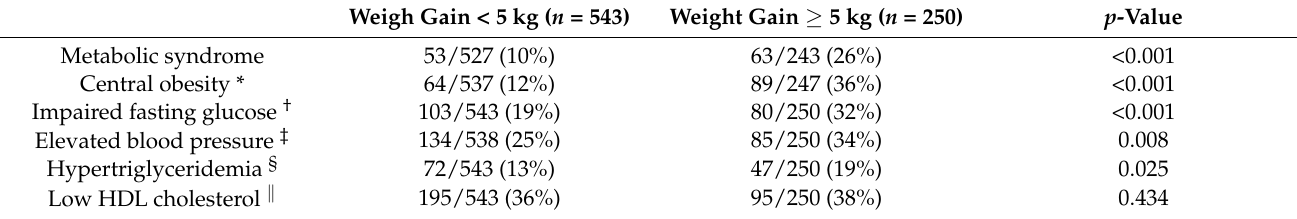
Table 2. Comparison of metabolic syndrome and its components according to degree of weight